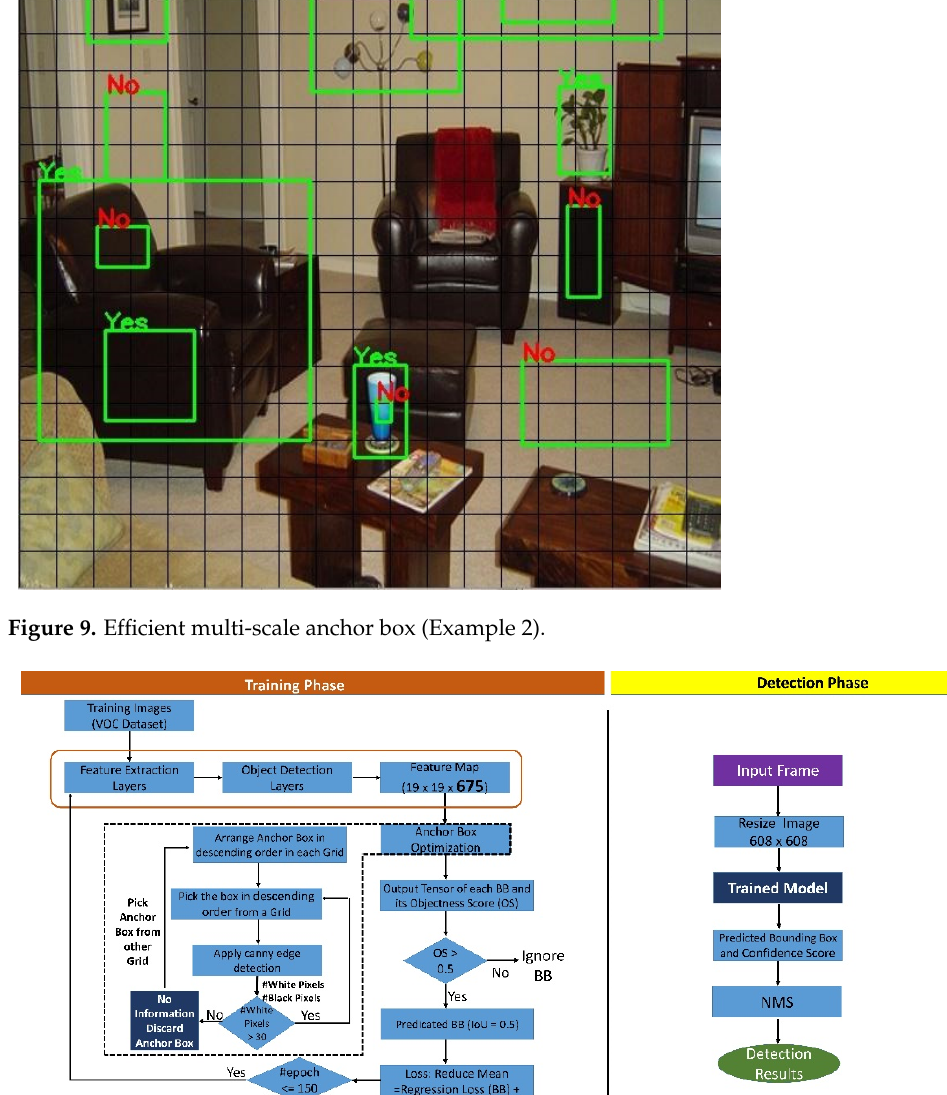
Figure 10. Flowchart of the training and detection phase of the proposed model.